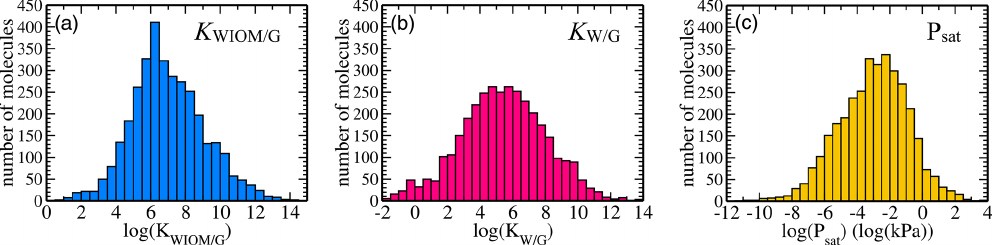
Figure 3. Dataset statistics: distributions of equilibrium partitioning coefficients (a) K WIOM/G , (b) K W/G , and (c) the saturation vapour pressure P sat for all 3414 molecules in the